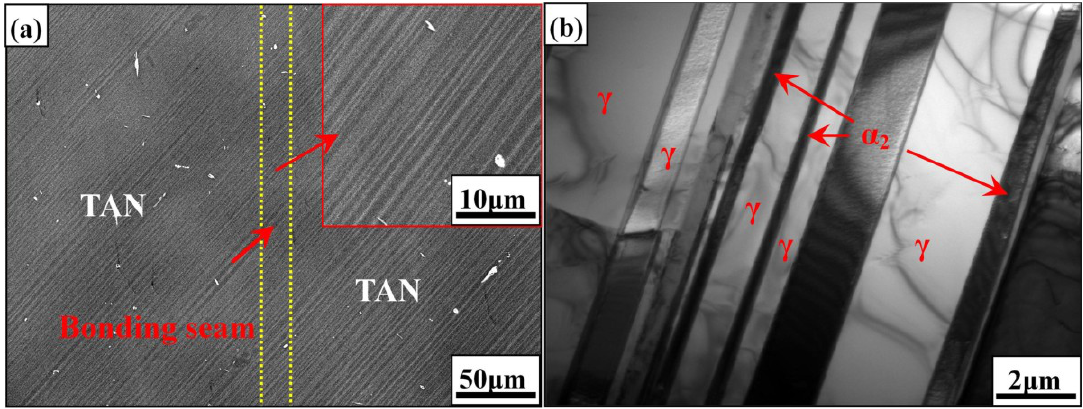
Figure 5. Interfacial microstructures of TiAl/Al/TiAl joint bonded at 1345 °C for 3.6 ks followed by stabilization at 900 °C for 1.8 ks and air cooling: ( a ) BEI and ( b ) transmission electron microscope (TEM) image (Reprinted with permission from